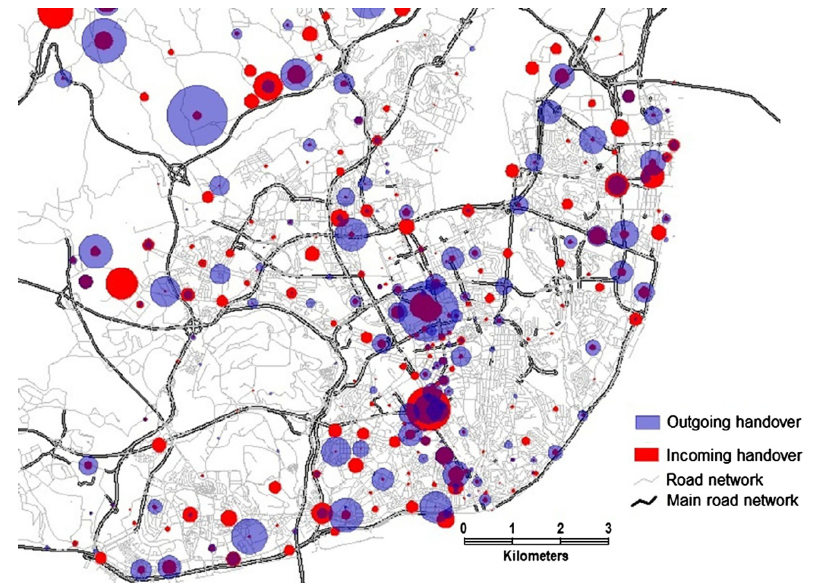
Figure 8. Map-based visualization of volume of incoming versus outgoing handover flows using sized circles